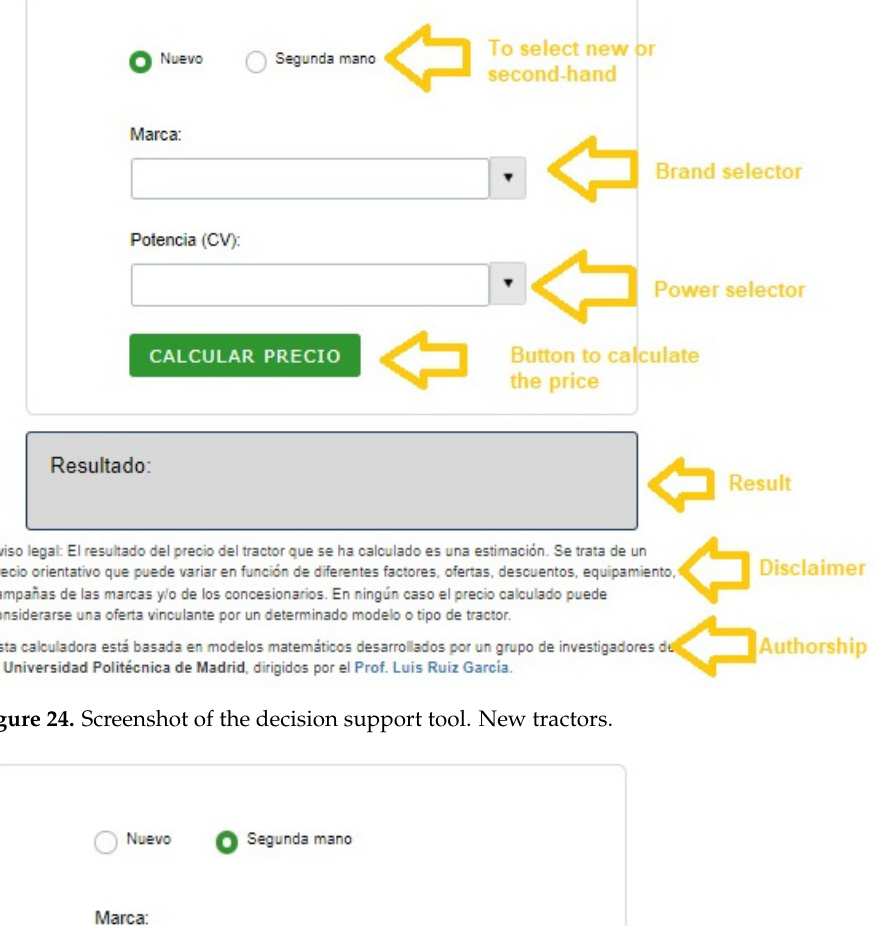
22 of 27 Table 13. Summary of results performing segmentation by official category in second-hand tractors. Categories